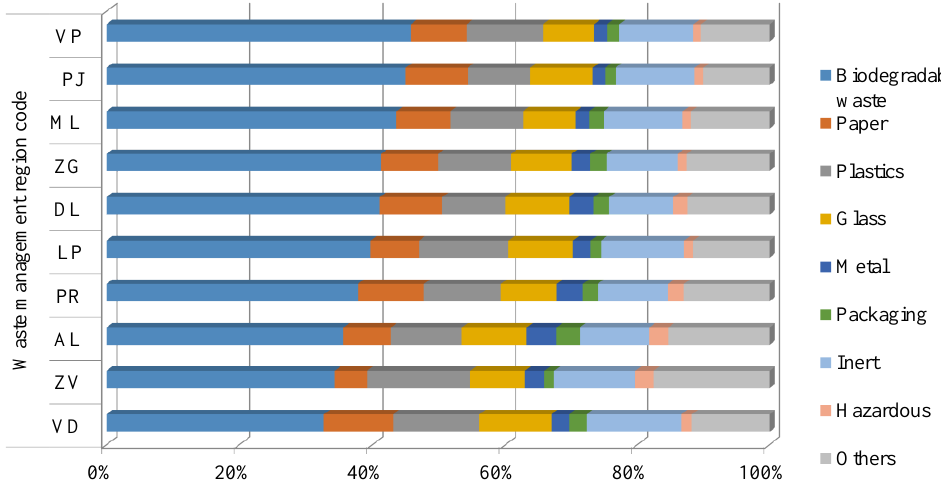
Fig. 3. Results of waste composition by waste management regions. (Note: only one city data was assessed for the ML region). The overall results indicate that the share of recyclables (glass, paper, plastics, metal) in different waste management regions average at 32 % of unsorted municipal waste. Of the separate fractions of recyclable waste, the highest difference between the regions is for plastic waste. The overall largest difference between the minimal and maximal values in different regions is for